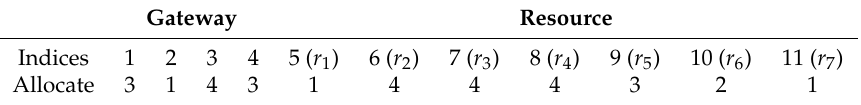
Table 2. A whale with 4 gateways and 7 resources.